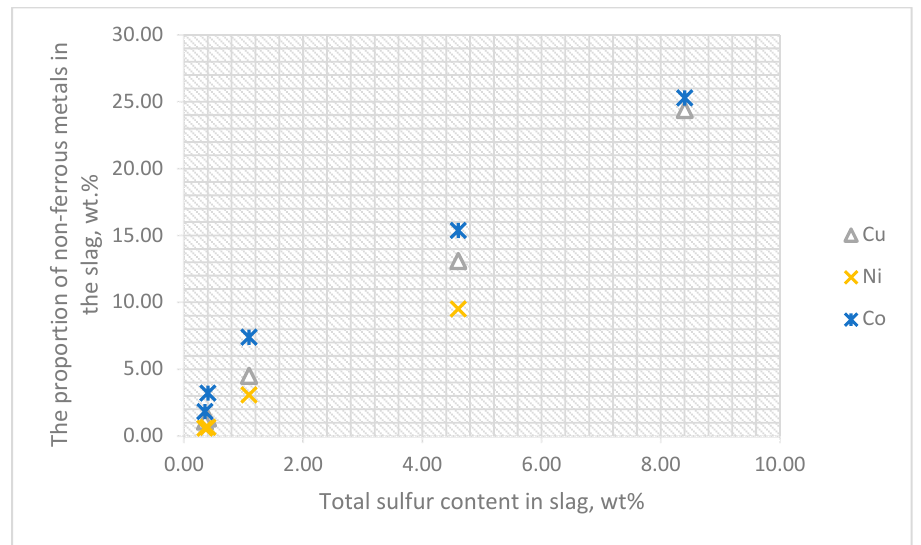
Figure 7. The proportion of non-ferrous metals in the slag, depending on the total sulfur content in it.